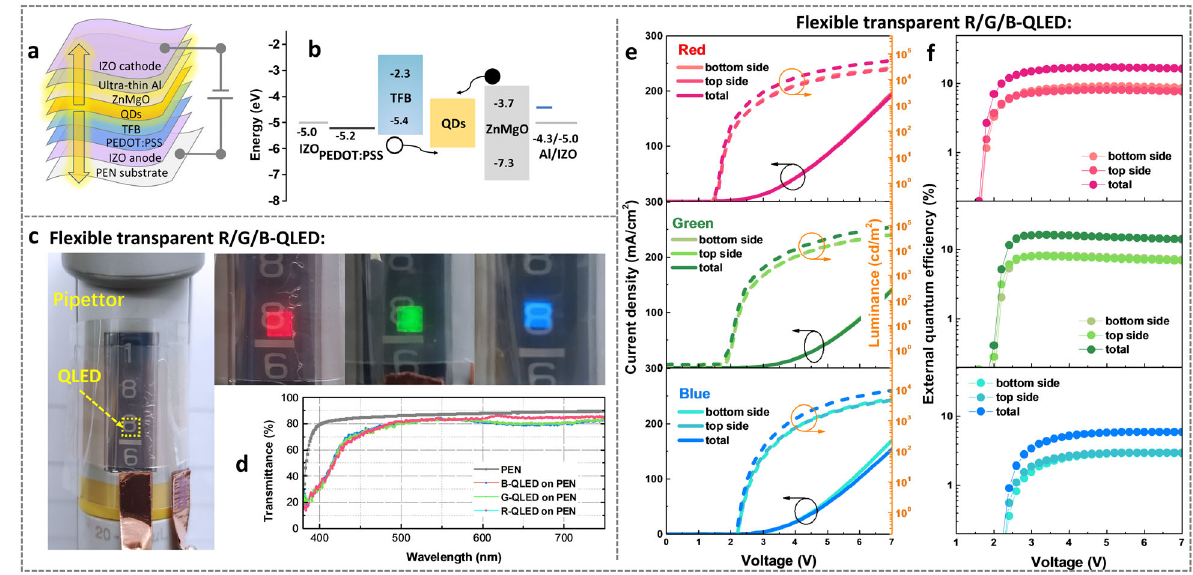
Fig. 1 Flexible and transparent R/G/B-QLED. a Schematic device structure and b energy levels of the functional layers of the transparent devices. c Photographs of the fl exible and transparent R/G/B-QLED attached to the pipettor no matter what the devices were on or off, the numeral below the devices can be clearly recognized, demonstrating a excellent transparency and fl exibility. d The transmittance of PEN and R/G/B-QLED. e The current density – voltage – luminance ( J – V – L ) and f the external quantum ef fi ciency – voltage (EQE – V ) characteristics of